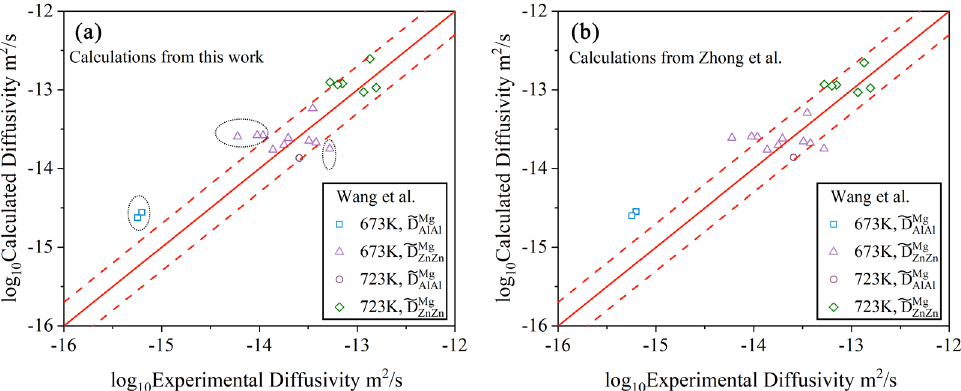
Figure 5. Model-predicted main inter-diffusivities in the hcp Mg–Al–Zn system due to ( a ) the present atomic mobilities and ( b ) Zhong et al. [32] at 673 and 723 K compared with the experimental data [36]. Along the diagonal lines, the model-predicted values are exactly equal to the experimental ones. The dashed lines represent the interdiffusion coefficients multiplied by a pre-factor of 2 or 0.5.